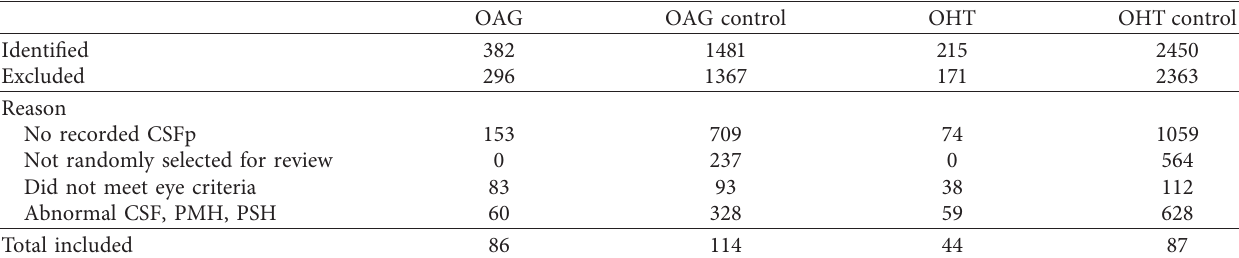
Table 1: Reasons for exclusion.